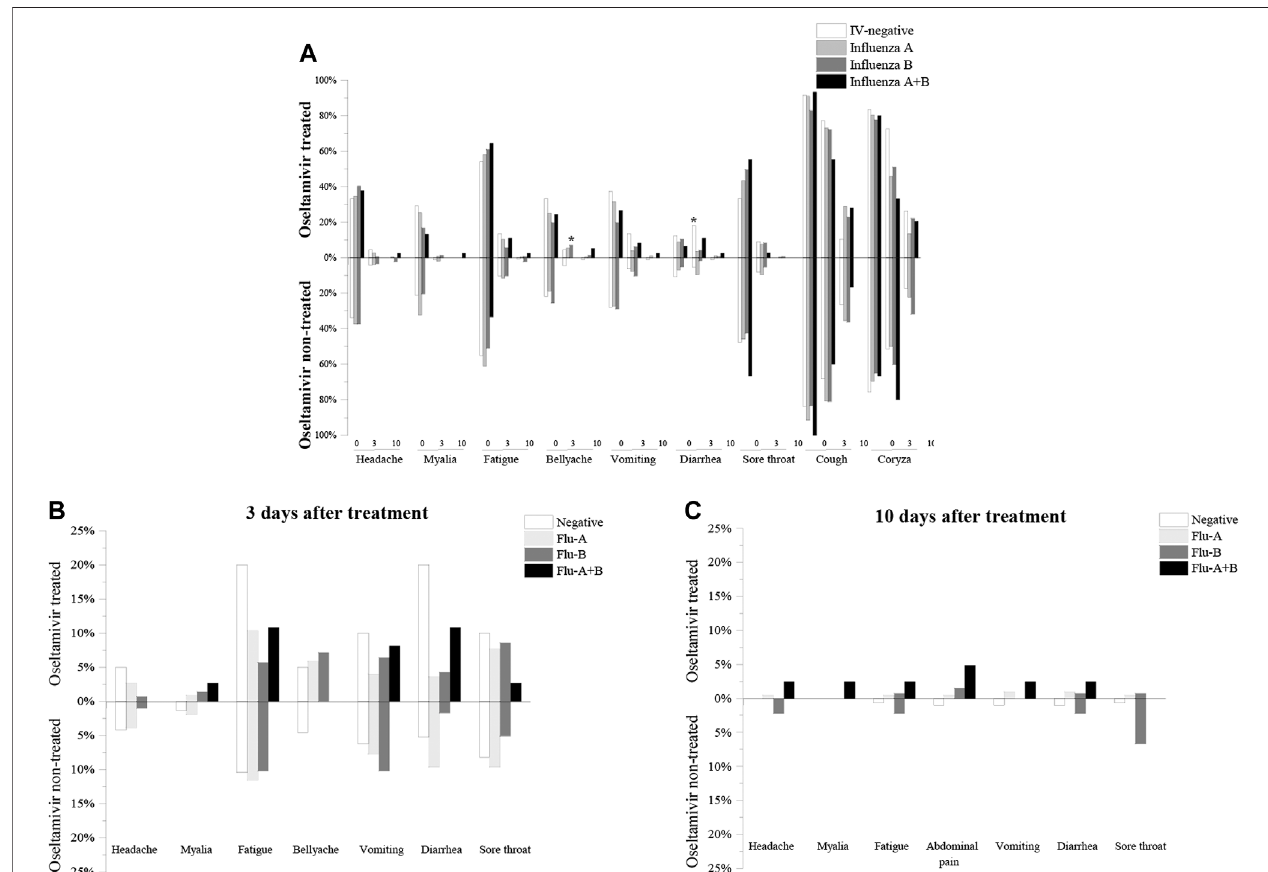
FIGURE 1 | Comparision of in fl uenza-like symptoms of oseltamivir treated and non-treated groups. (A) : Percentage of in fl uenza-like symptoms of oseltamivir treatedand non-treated groups beforetreatment. (B) : Percentage ofin fl uenza-like symptoms ofoseltamivirtreated and untreated groups after 3 days oftreatment. (C) : Percentage of in fl uenza-like symptoms of oseltamivir treated and untreated groups after 10 days of treatment.